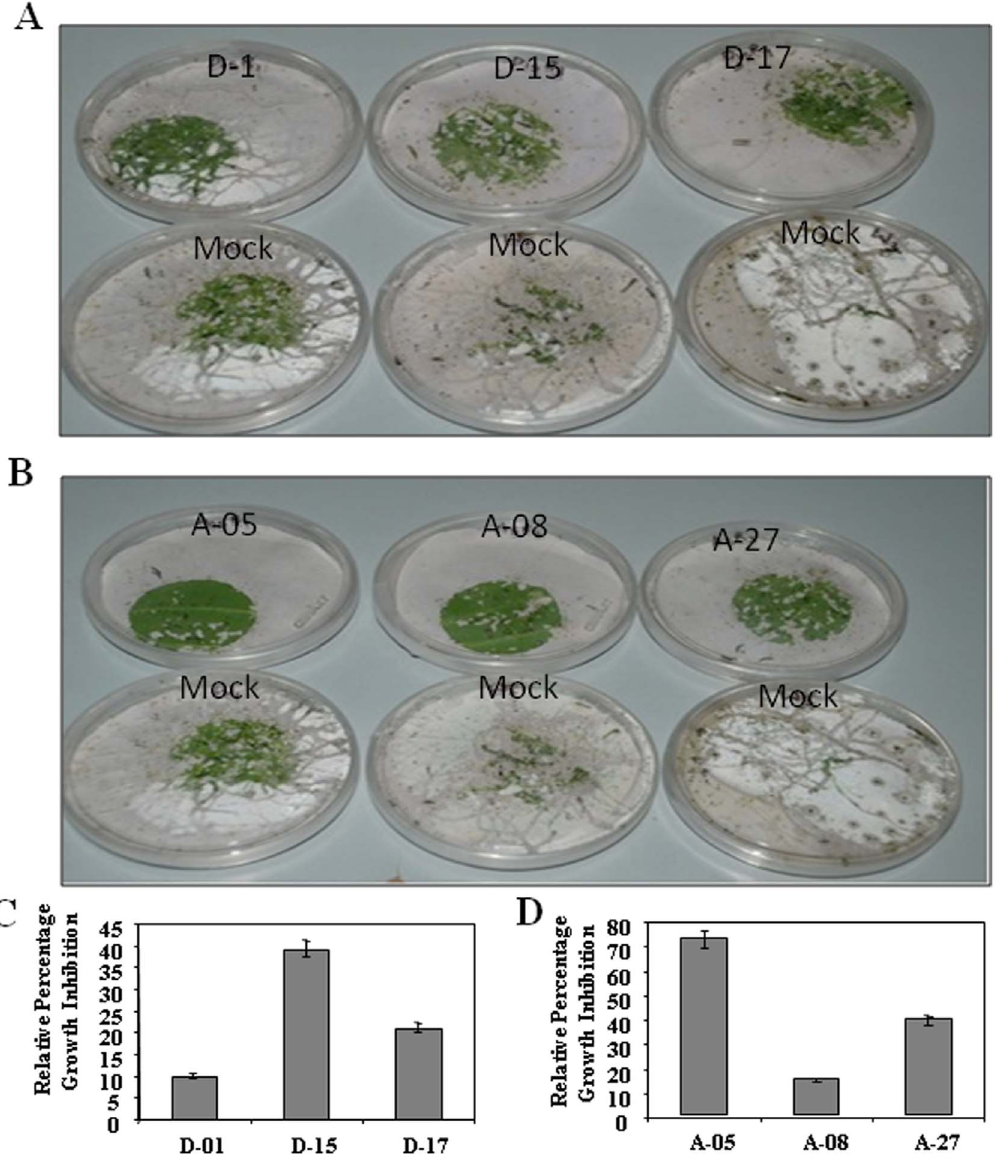
Figure 7. CsDFR and CsANR overexpression provided anti-herbivores effect against S.litura in transgenic tobacco. The picture showed less feeding by S. litura on leaf discs of CsDFR transgenic tobacco line (A) and CsANR transgenic tobacco line (B) as compared to leaf discs of control tobacco plants. The relative percentage growth inhibition of S. litura feeding on leaf discs of selected CsDFR lines (C) and CsANR lines (D) as compared to relative percentage growth inhibition on leaf discs of control tobacco plants. Data is the mean of three replications with error bars indicating 6